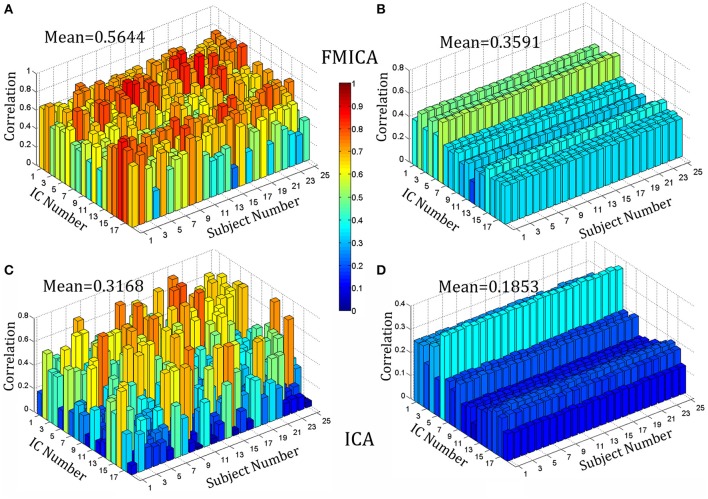
The correlation bar chart of 18 intrinsic BFNs against 25 subjects on the test-retest resting-state datasets: (A) denoted the mean across-sessions correlation among the intrinsic BFNs estimated by FMICA for the different sessions of the same subject; (B) denoted the mean across-subjects correlation among the intrinsic BFNs estimated by FMICA for the different subjects; (C) denoted the mean across-sessions correlation among the intrinsic BFNs estimated by FastICA for the different sessions of the same subject; (D) denoted the mean across-subjects correlation among the intrinsic BFNs estimated by FastICA for the different subjects.